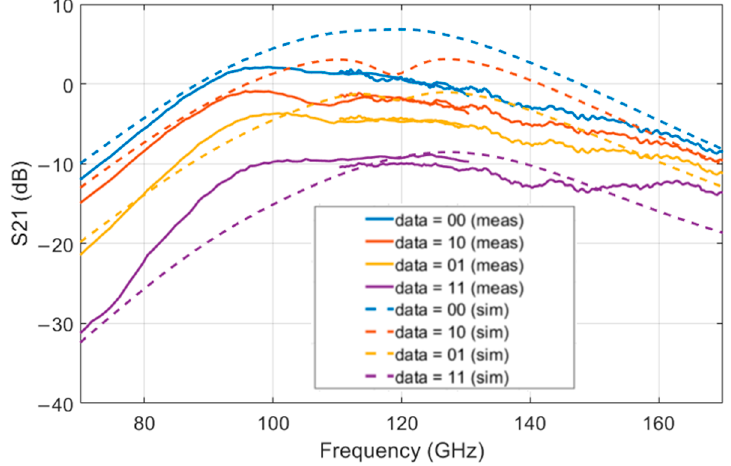
Figure 5. S21 for the different digital data input. LO is port 1 and RF is port 2. The measured results are shown in the solid lines and the simulated results in the dashed lines. The LO input power is − 6 dBm.